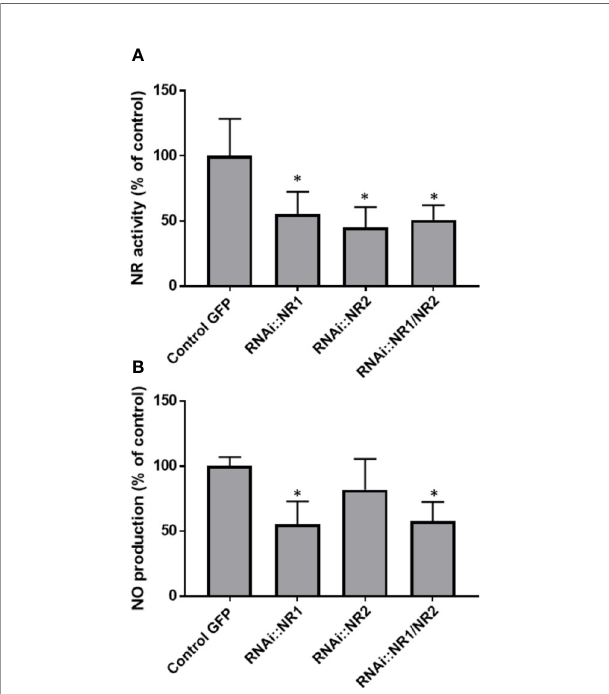
FIGURE 6 | NR activity and NO production in NR RNAi transformed Medicago truncatula nodules. (A), NR activity is expressed in nmol per min per g of fresh weight. (B) , The fl uorescence intensity of the NO production was measured using the DAF-2 fl uorescent probe. Data are means ± SE of three biological replicates. Each measure was realized in three technical replicates. Asteriks * indicate statistical difference when compared with the control GFP (transgenic roots transformed with empty pK7GWIWG5D(II) vector selected on GFP marker) at P < 0.05 according to Student ’ s t test. FU, fl uorescence